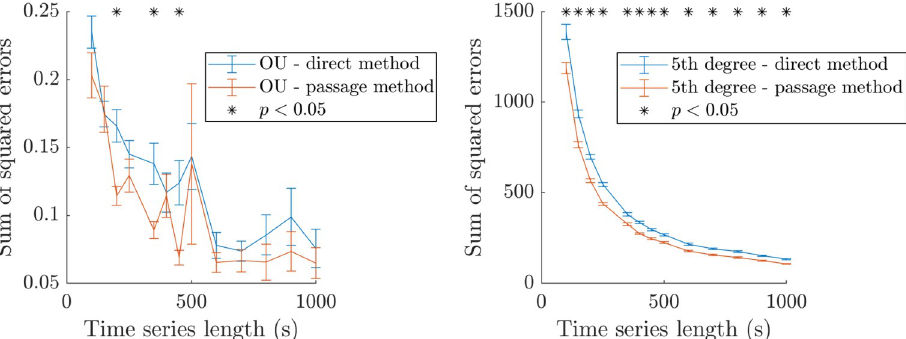
Fig 12. Comparison of the passage method and the direct method on synthetic data. Showing the sum of squared errors between the inferred and ground truth μ functions for both methods as a function of the duration of synthetic data used for inference. The synthetic data were generated from an OU process (left) and a fifth degree polynomial (right). In both cases, the mean value of the sum of squared errors and the SEM error bars are obtained for a large number of repeats (150 repeats from 100 s to 250 s, 100 repeats from 350 s to 450 s, and 50 repeats from 500 to 1000 s). Significant differences are highlighted by black stars (t-tests under FDR control, same sample sizes as for error